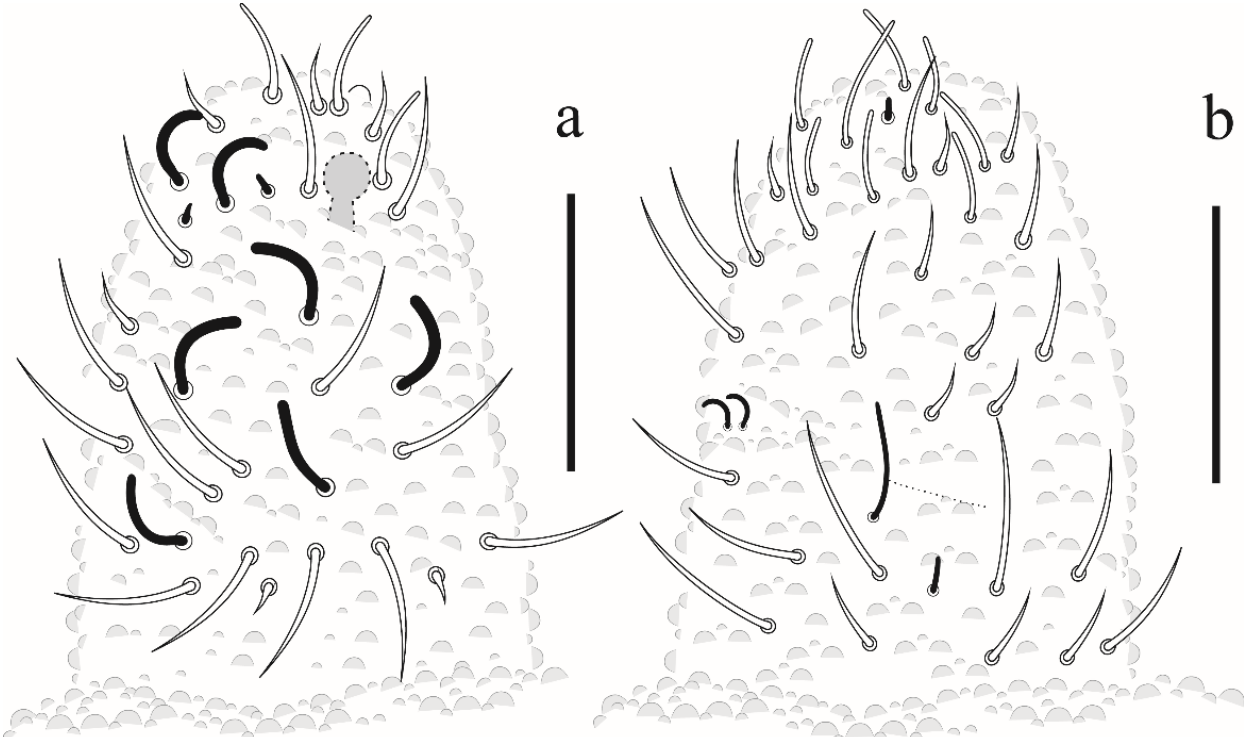
Figure 7. Friesea rochedoensis sp. nov. ( a ) dorsal view of antenna, scale bar: 20 µm. ( b ) ventral view of antenna, scale bar: 20 µm.